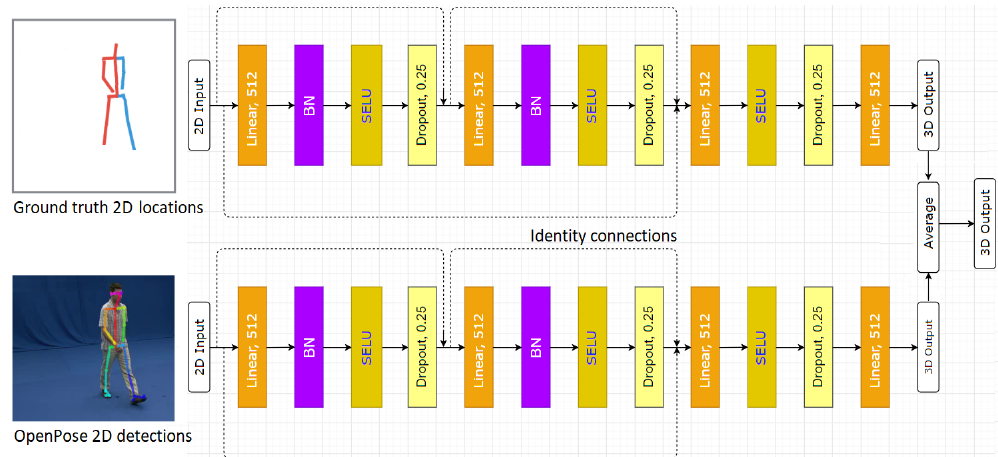
Figure 2. Diagram of the proposed two-stream network for training the 3D pose